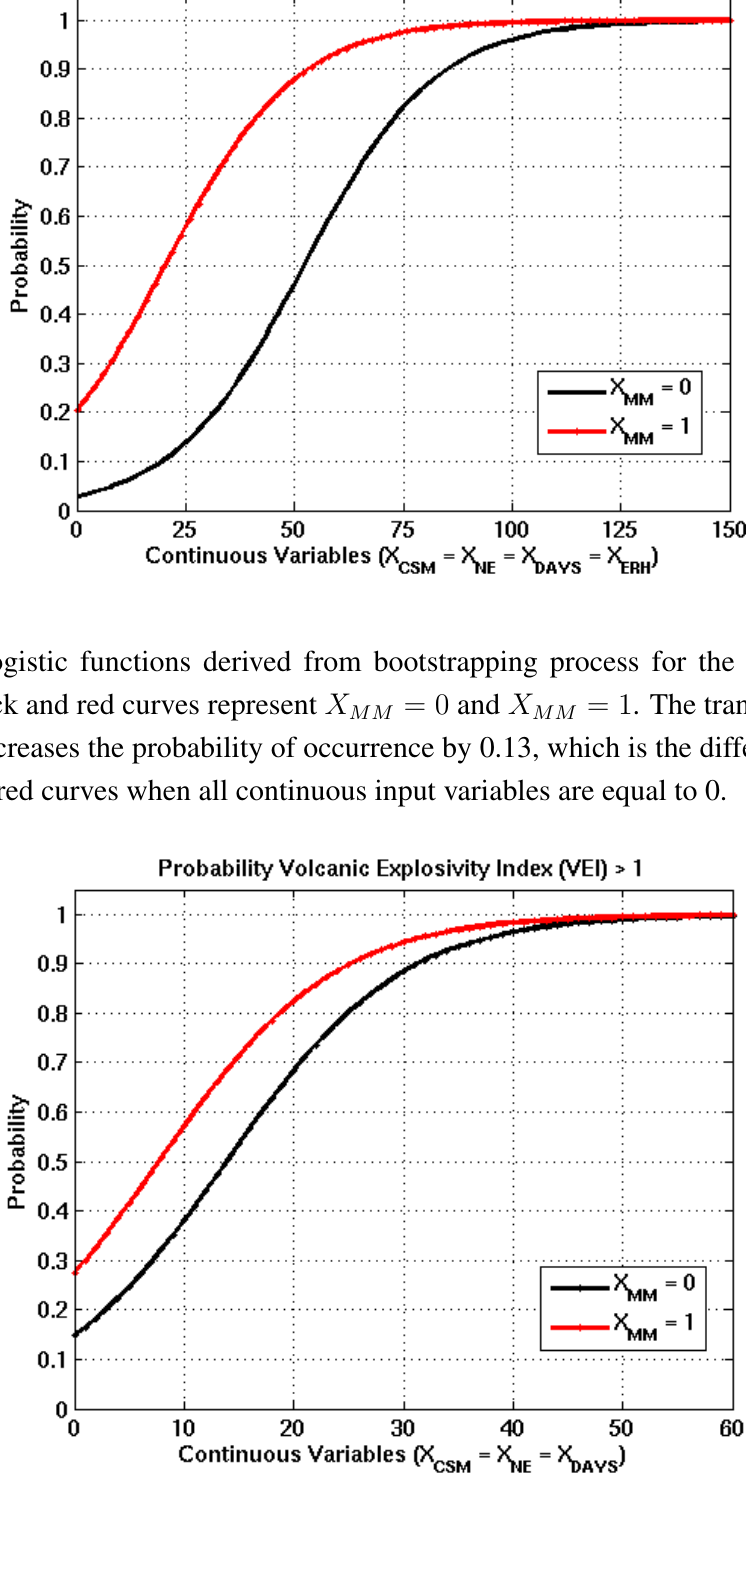
Figure 3. Logistic functions derived from bootstrapping process for the Eruption node, where the black and red curves represent X from 0 to 1 increases the probability of occurrence by 0.17, which is the difference between the black and red curves when all continuous input variables are equal to 0.